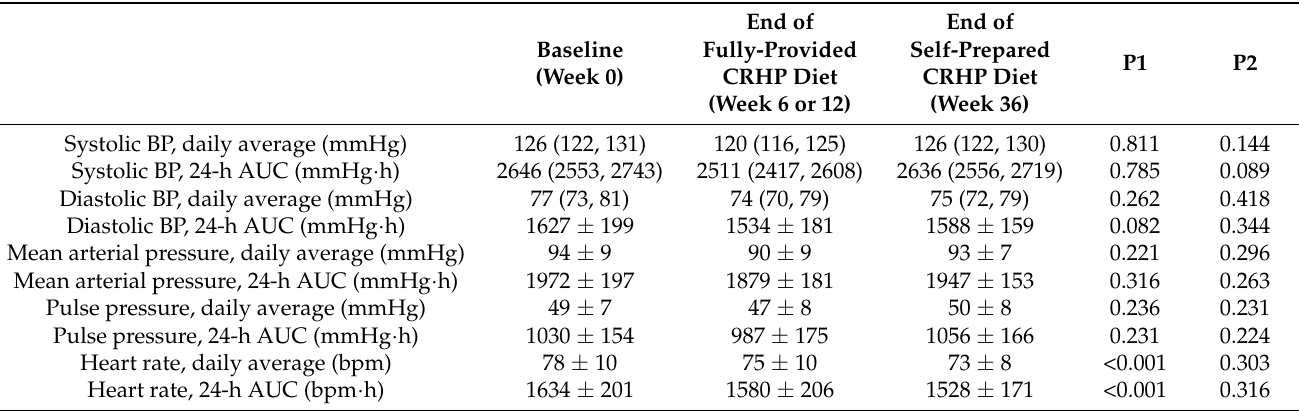
Table 3. Effects of a CRHP diet on blood pressure and heart rate in patients with